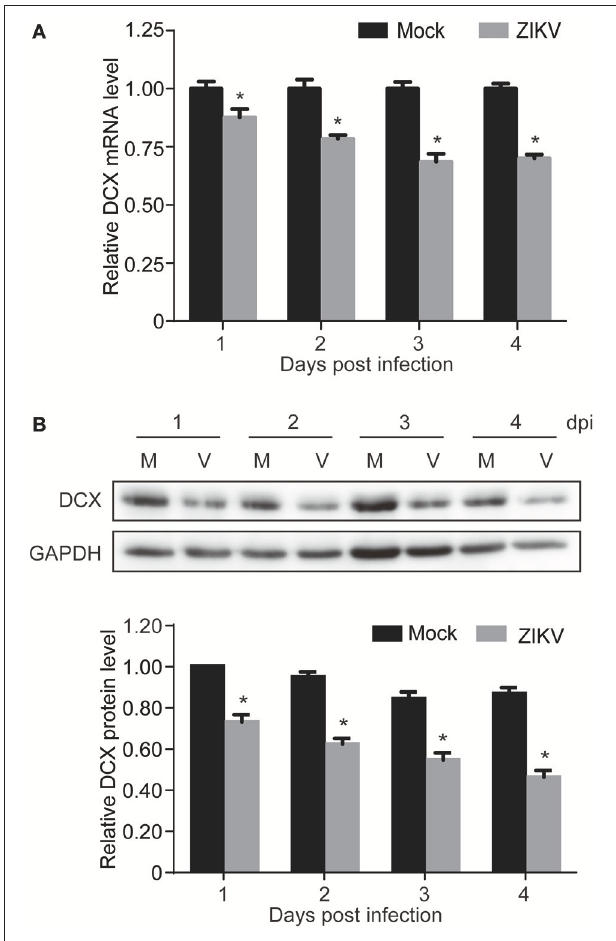
FIGURE 5 | ZIKV infection downregulates DCX in NPCs. NPCs were ZIKV- (V) or mock-infected (M) at an MOI of 3. Infected cells were harvested at the indicated times for DCX mRNA and protein levels analyses. (A) DCX mRNA level. Total RNA was extracted from ZIKV- or mock-infected NPCs, reverse-transcribed and DCX mRNA level was assessed by qRT-PCR. Relative DCX mRNA levels in ZIKV-infected NPCs at each time point were normalized to GAPDH mRNA levels and expressed as fold changes relative to mock-infected NPCs. Data were presented as the mean ± SEM from 3 independent experiments. (B) DCX protein level. Cell lysates were prepared from infected NPCs. Protein levels were determined by immunoblotting assay. GAPDH was served as a loading control. The DCX levels were quantified by densitometric analysis using ImageJ software and normalized to mock-infected cells at each time point. Data were presented as the mean with SEM of 3 independent experiments. * p <